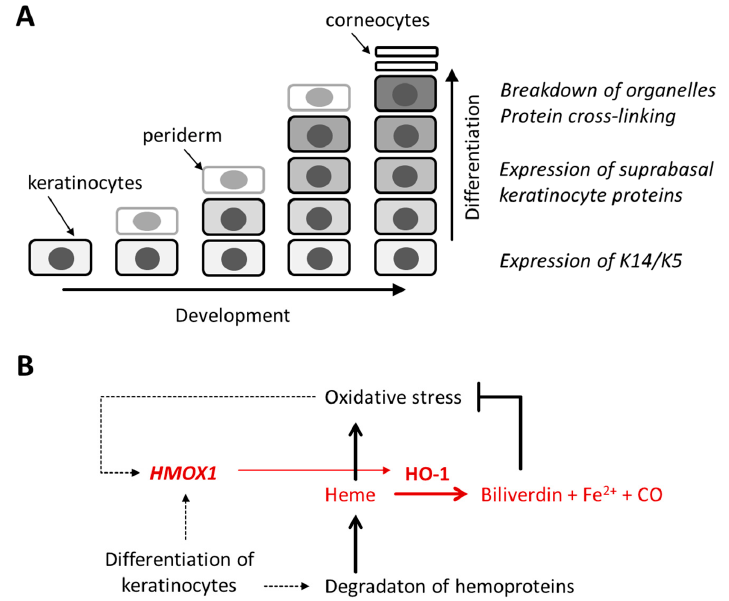
Figure 1. Hypothesis on the role of heme oxygenase-1 in the epidermis. ( A ) Schematic model of epidermal development and keratinocyte differentiation. K, keratin. ( B ) Regulation and function of heme oxygenase-1 (HO-1). The expression of the HMOX1 gene is induced by oxidative stress in many cell types including keratinocytes. Differentiation of keratinocytes is hypothesized to alter the expression of HMOX1 and to cause degradation of hemoproteins, thereby releasing heme. The latter is converted by HO-1 into biliverdin, ferrous iron (Fe 2+ ) and carbon monoxide (CO). To test the hypothesis that HO-1 is critically involved in terminal differentiation of epidermal keratinocytes, we determined the expression pattern of HO-1 in the skin of humans and mice, deleted Hmox1 in keratinocytes of mouse skin and investigated the phenotype of mice lacking epithelial HO-1. 2. Materials and Methods 2.1. Ethics Statement Human tissue samples were obtained from abdominal skin reduction surgery procedures. Informed consent was obtained. The study was conducted according to the guidelines of the Declaration of Helsinki and approved by the Ethics Committee of the Medical University of Vienna (approval EK. 1969/2021, date of approval 18 November 2021). Mouse tissue samples were prepared from mice immediately after killing the animals. The Ethics Committee of the Medical University of Vienna decided that, in agreement with the national laws of Austria, a permission for killing mice for organ preparation was not required. 2.2. Mice Hmox1 f/f mice [22] were crossed with K14-Cre mice [23] to generate Hmox1 Δ ep ( Hmox1 f/f K14-Cre ) mice in which Hmox1 is deleted in epidermal keratinocytes. The mice were kept on a 12-h light and dark cycle and had access to chow and water ad libitum. Genotyping of